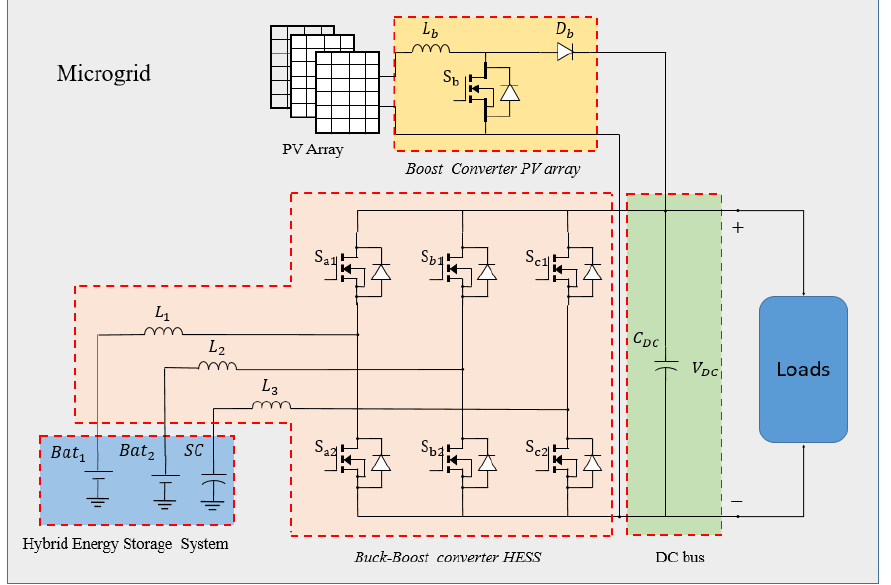
Figure 1. Microgrid